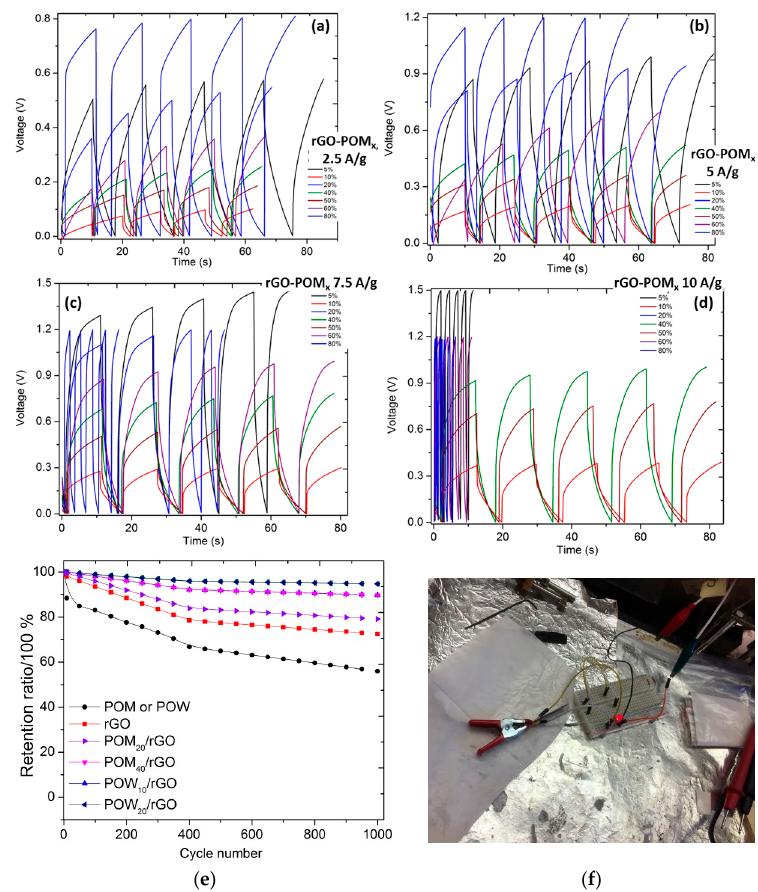
Figure 3. ( a – d ) Galvanostatic charge–discharge (V–t) profiles for rGO–POM x series at 2.5, 5, 7.5 and 10 A·g − 1 current densities; ( e ) plots of cycle life tests; and ( f ) an LED indicator powered by